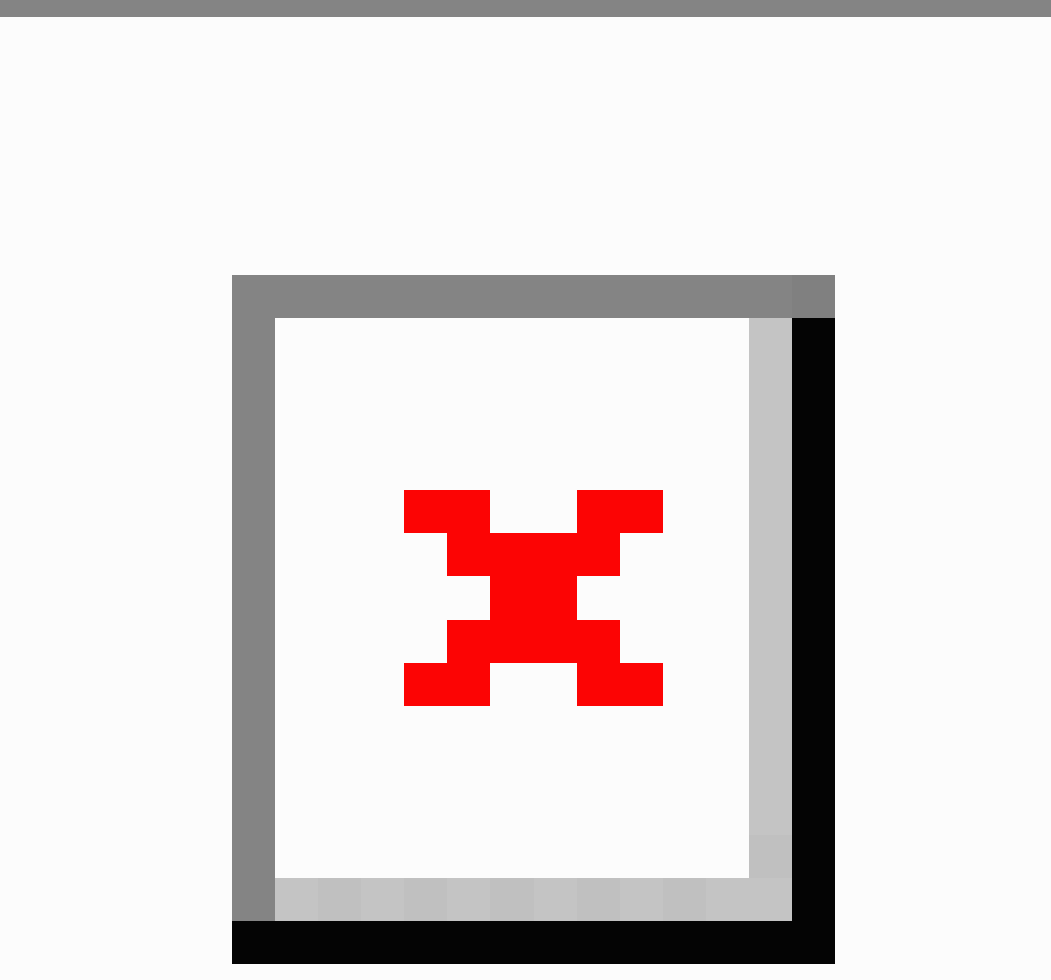
Figure 1. Antenna sites: 1050 Riverside Dr, New York, NY 10032. [Magnification 1]. Blue/single antennas indicate a small (below 100ft) stand-alone antenna on top of a structure, and a red/double antenna indicates multiple antennas sharing a high tower